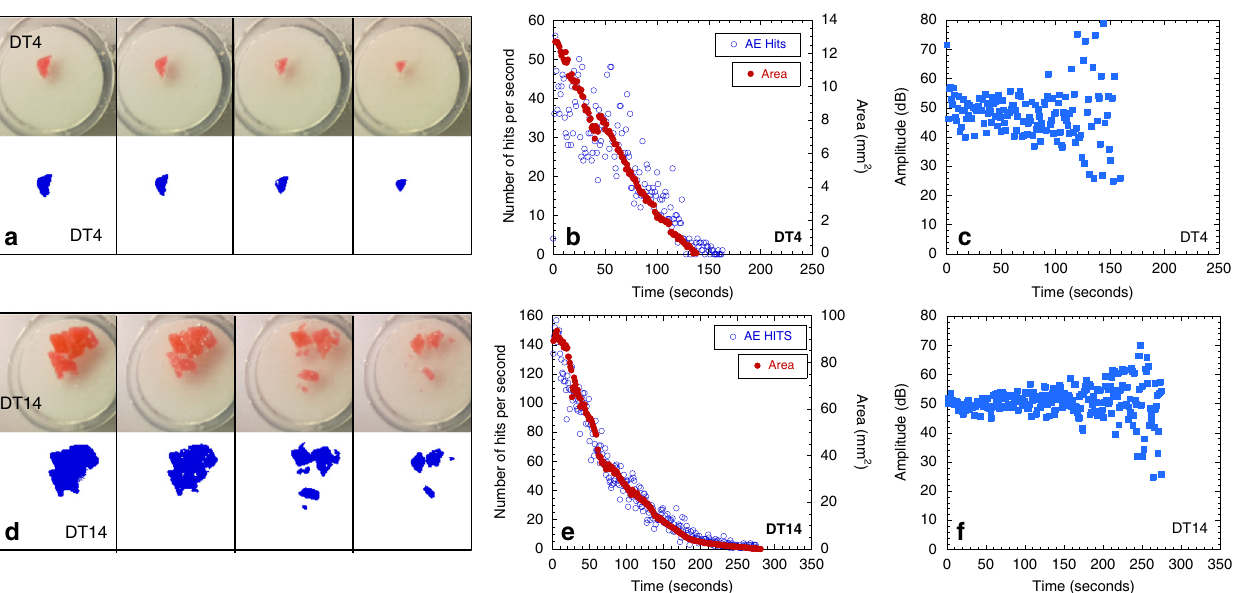
Fig. 3 Dissolution of a dust grain. a , d A digital image showing a dust grain sitting in a petri dish over an AE sensor, and segmented images of the dust for sample DT4, which did not disaggregate and sample DT14, which disaggregated. b , e Change in grain size area and number of hits per second as a function of time for samples DT4 and DT14. c , f Average signal amplitude as a function time for samples DT4 and DT14.